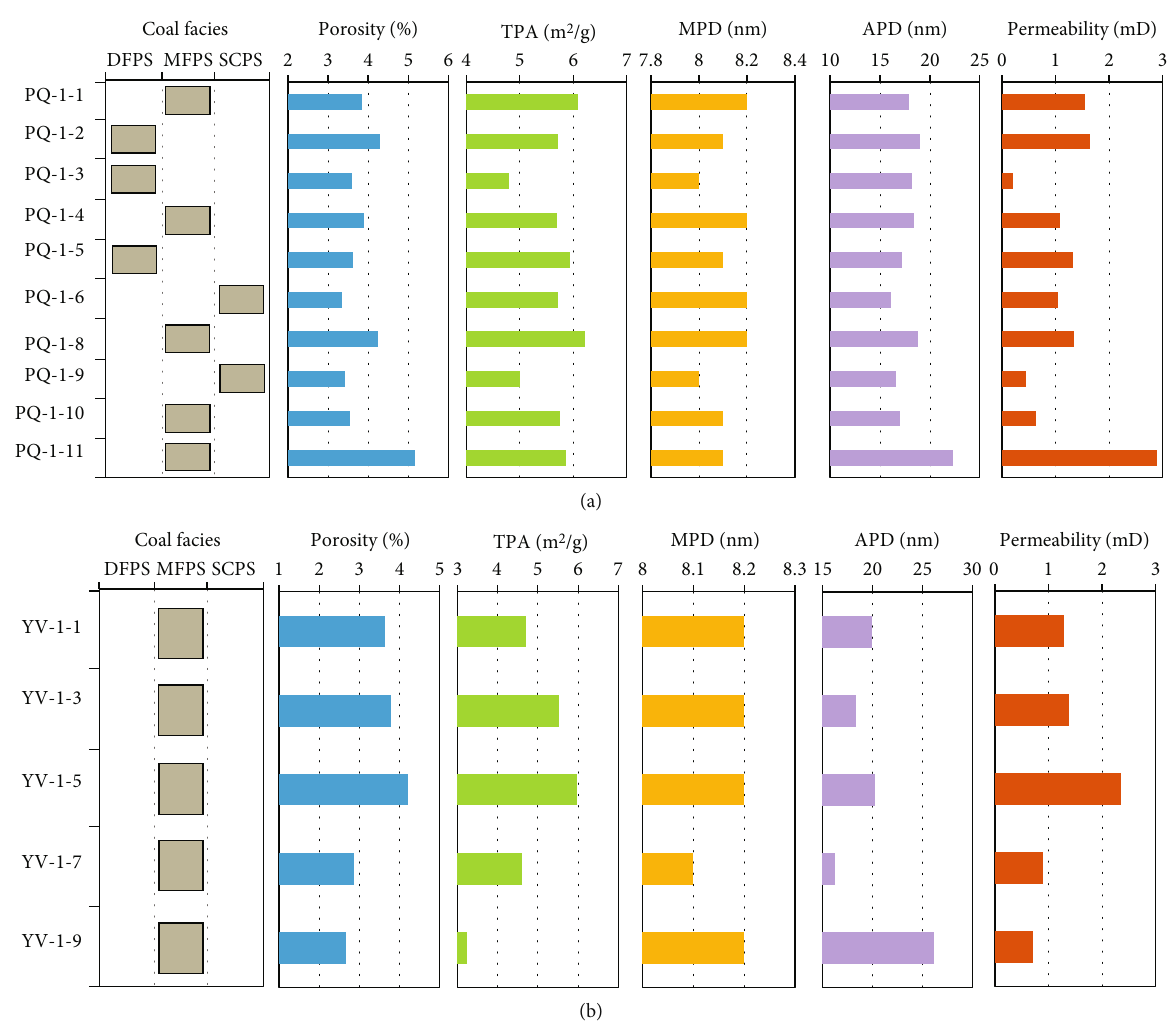
Figure 8: Porosity, total pore area (TPA), median pore diameter (MPD), average pore diameter (APD), and permeability of moist forest peat swamp facies (MFPS), shallow-water covered forest peat swamp facies (SCPS), and dry forest peat swamp facies (DFPS) samples based on mercury intrusion porosimetry experiment data. (a) PQ-1 well; (b) YV-1